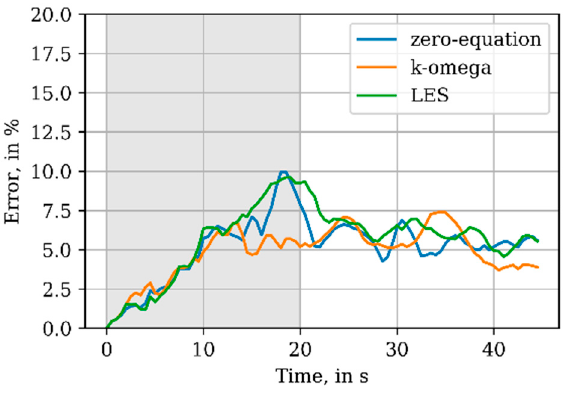
Figure 11. Time series of relative errors E i for ( a ) zero-equation, ( b ) k-omega, and ( c ) LES models. Figure 12 compares the time series of the spatial mean relative errors. The LES and zero-equation models give the highest errors, whereas the k-omega model presents the lowest spatial mean relative error through time.